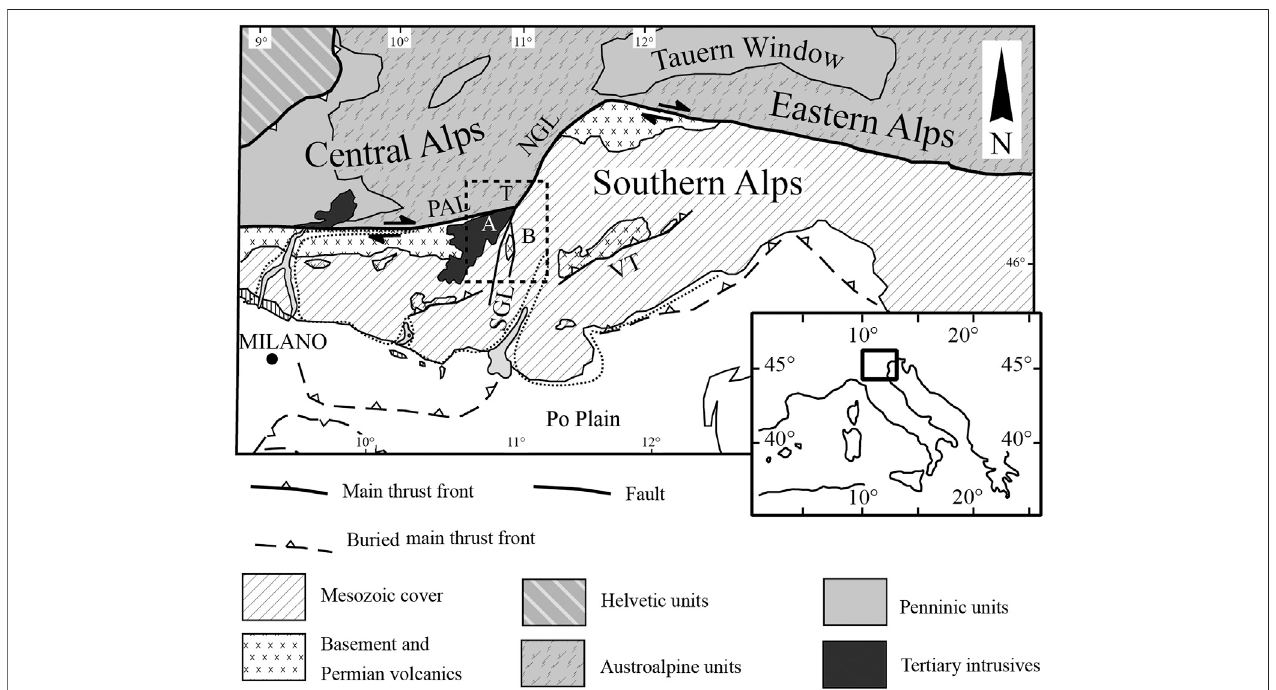
FIGURE1| GeographicoverviewoftheAdamello(A),Brenta (B),Tonale (T)massifsintheframeoftheSouthernand Central Alps.Thedotted boxisapproximately the area of Figure 2 . (Modi fi ed from Reverman et al., 2012). PAL (cid:2) Periadriatic Line; NGL (cid:2) Northern Giudicarie Line; SGL (cid:2) Southern Giudicarie Line; VT (cid:2) Valsugana Thrust.